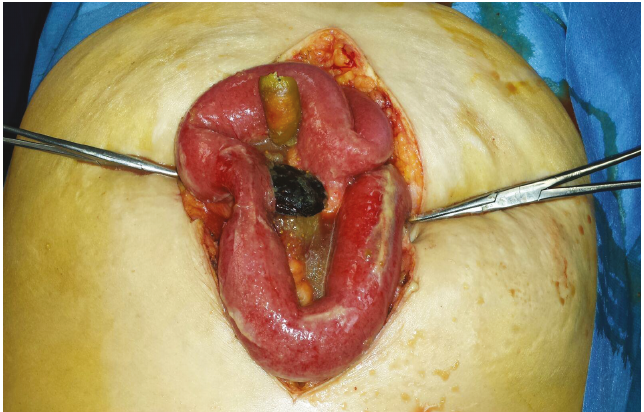
Figure 1: View of the abdomen at the opening of the peritoneum.